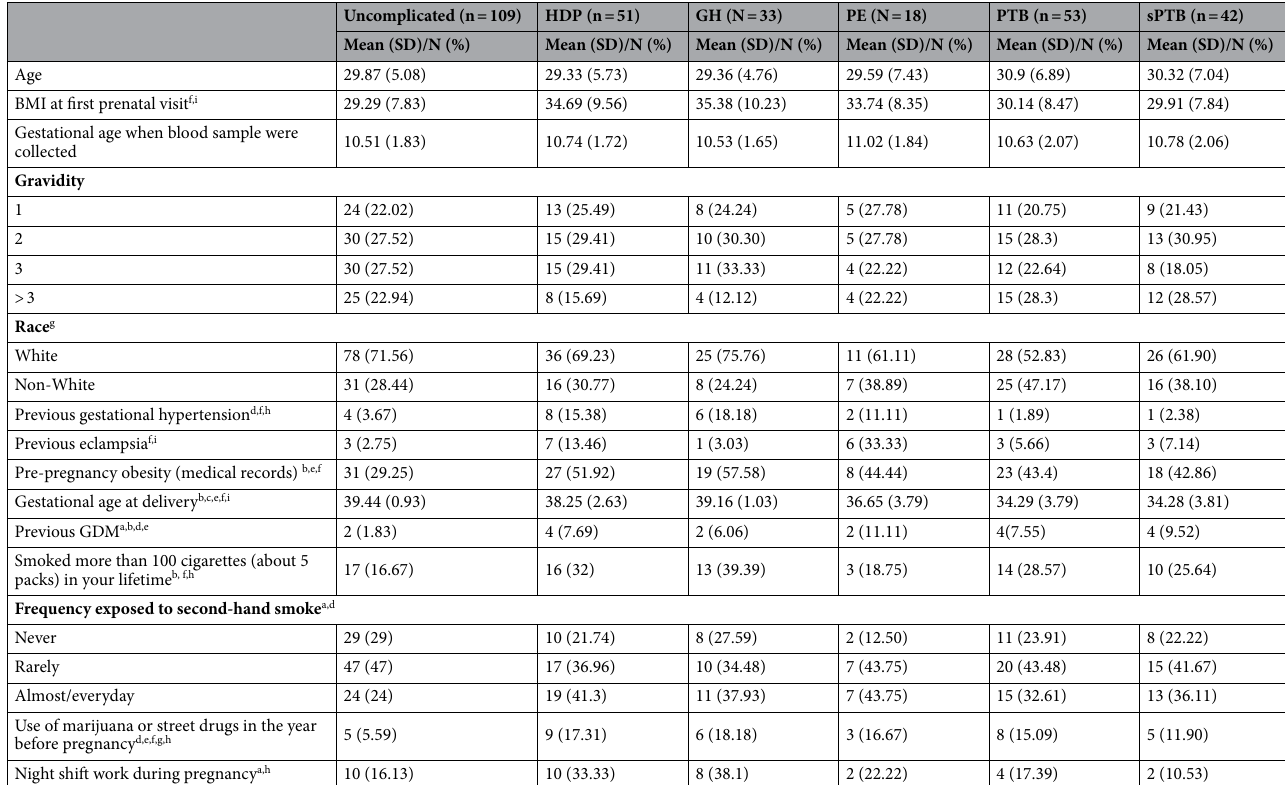
Table 1. Demographic, medical, and lifestyle characteristics of cases and controls. Mean (SD): for continuous variables, mean and standard deviation are displayed; N (%): for categorical variables, number and percentage in case/control are displayed. HDP, any hypertensive disorder of pregnancy; GH, gestational hypertension; PE, pre-eclampsia, PTB, preterm birth; sPTB, spontaneous preterm birth; GDM, gestational diabetes mellitus. a p < 0.2 (criterion for further inclusion in models) comparing HDP cases to controls. b p < 0.2, PTB cases